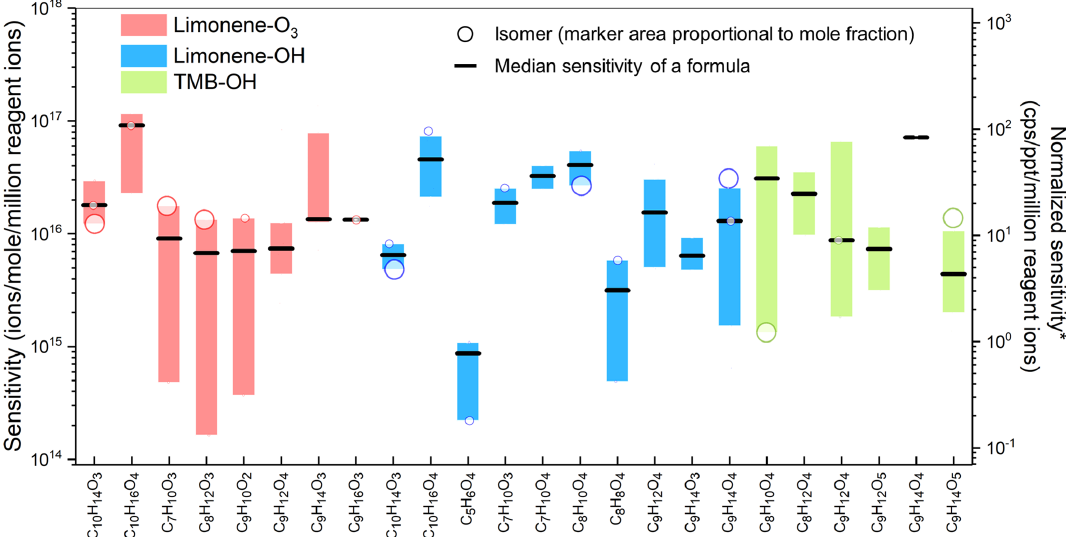
Figure 3. Sensitivities of constituent isomers of formulas for which at least two isomers had sensitivities obtained in the oxidation experi- ments. Each circle shows the sensitivity of an isomer, and the area of the circle represents the mole fraction of the isomer in the formula. Boxes represent the first to third quartiles. Black lines are the median values of the sensitivities. ∗ : unit converted for direct-air-sampling CIMS using 100mbar in IMR, 2slpm sample flow rate, and 2slpm reagent ion flow